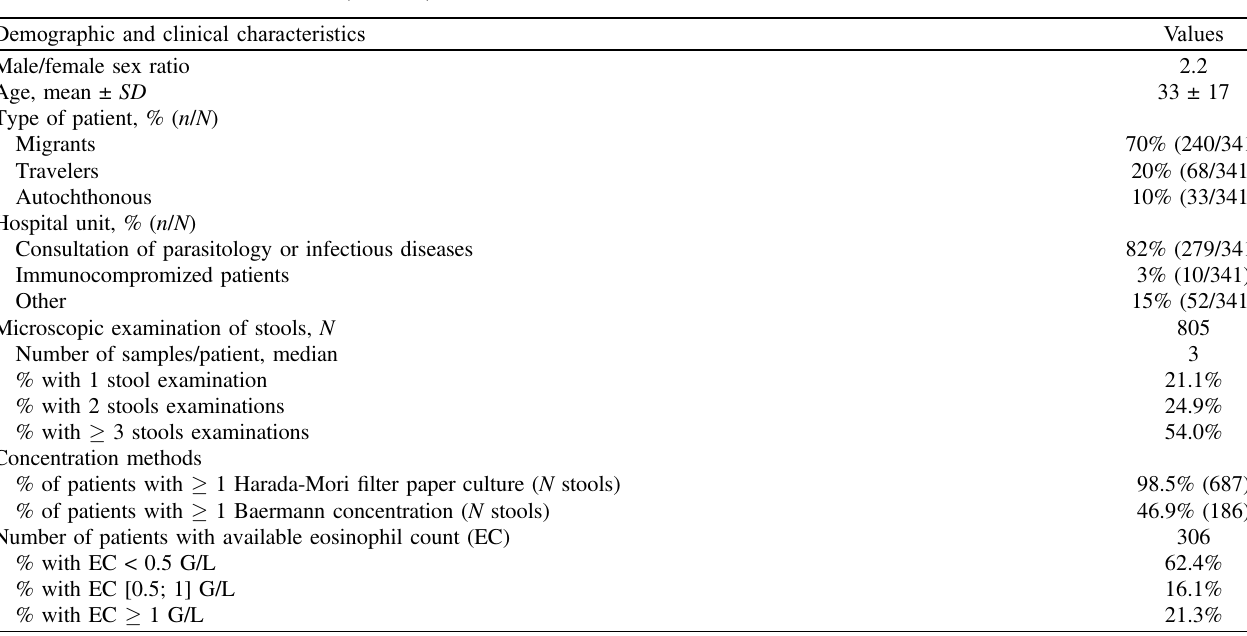
Table 2. Characteristics of the cohort ( N =